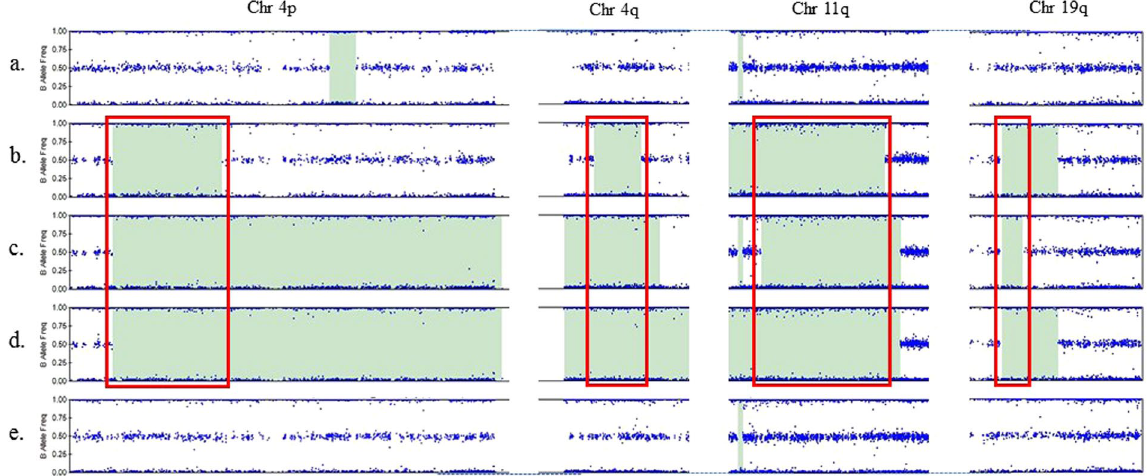
Figure 2. B allele frequency (BAF) (blue dots) is defined as the estimated number of B alleles divided by the sum of both alleles at a given SNP location. A BAF of 0 represents the genotype (A/A or A/ − ), 0.5 represents (A/B) and 1 represents (B/B or B/ − ). The green areas represent regions of homozygosity. The figure illustrates chromosomes 4, 11 and 19 with shared homozygous regions highlighted with a red box. Sample IDs: ( a ) mother (IV-4), ( b ) affected child (V-1), ( c ) affected child (V-2), ( d ) affected child (V-4), ( e ) father (IV-3).